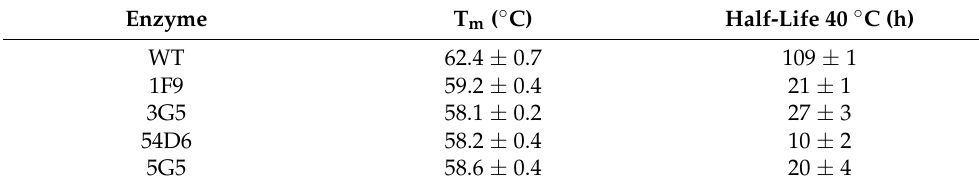
Table 5. Thermal stability of wild-type and variant enzymes as monitored by fluorescence emission (tertiary structure) at 330 nm and thermal inactivation at 40 ◦ C. T m is the melting temperature, where 50% of the protein molecules are unfolded. Half-life at 40 ◦ C is the time after which 50% of activity is achieved. Assays were performed in